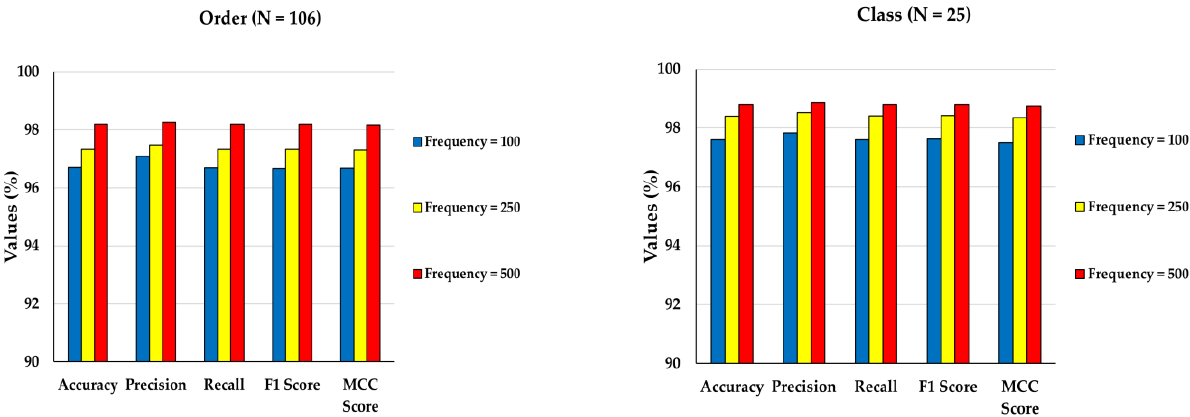
Figure 6. Average values (%) of evaluation metrics obtained from CNN models for balanced datasets at all taxonomic levels with invariant diversity levels and hexamer nucleotide frequency features. In each level, three datasets with 100, 250 and 500 data points per category are considered.